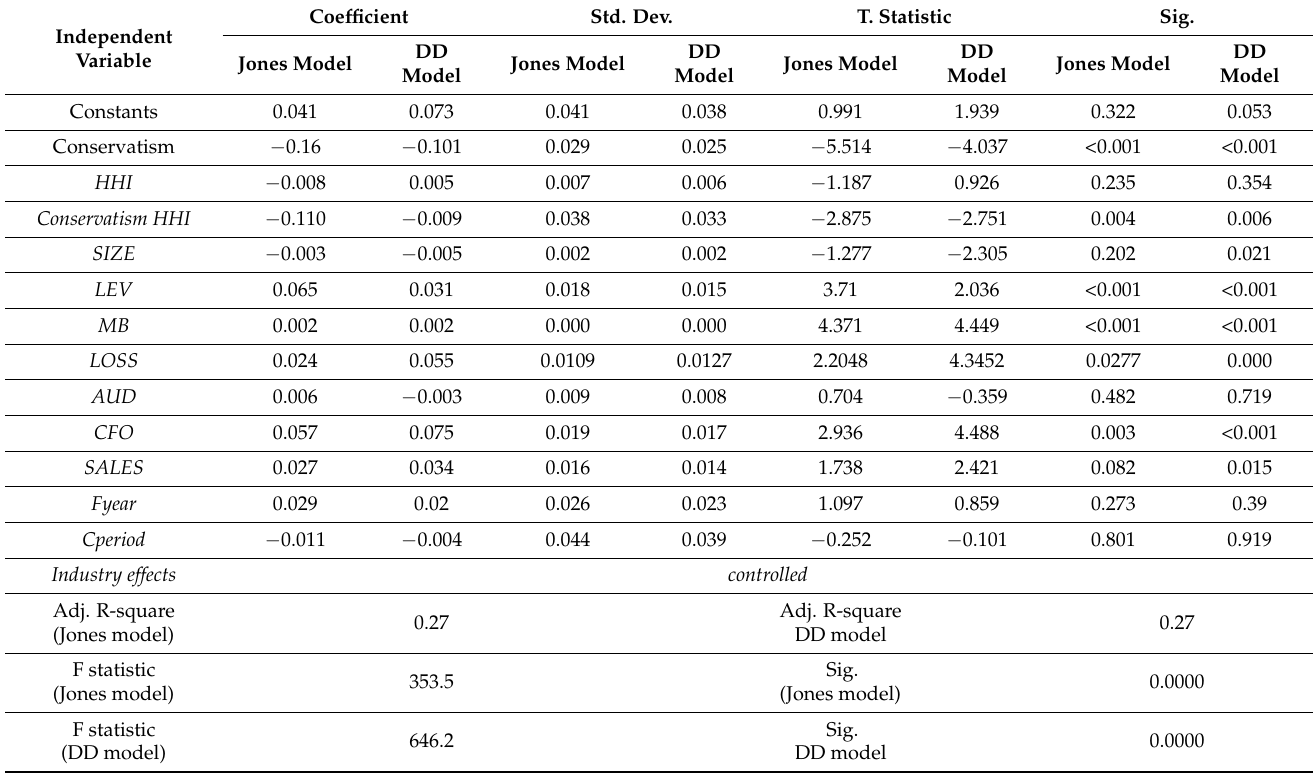
Table 5. The results of the fourth hypothesis